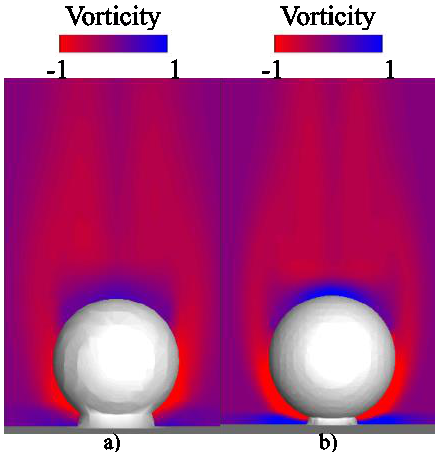
Figure 10. Vorticity distributions at the particle – flat wall collision: ( a ) coarse mesh, ( b ) fine mesh.